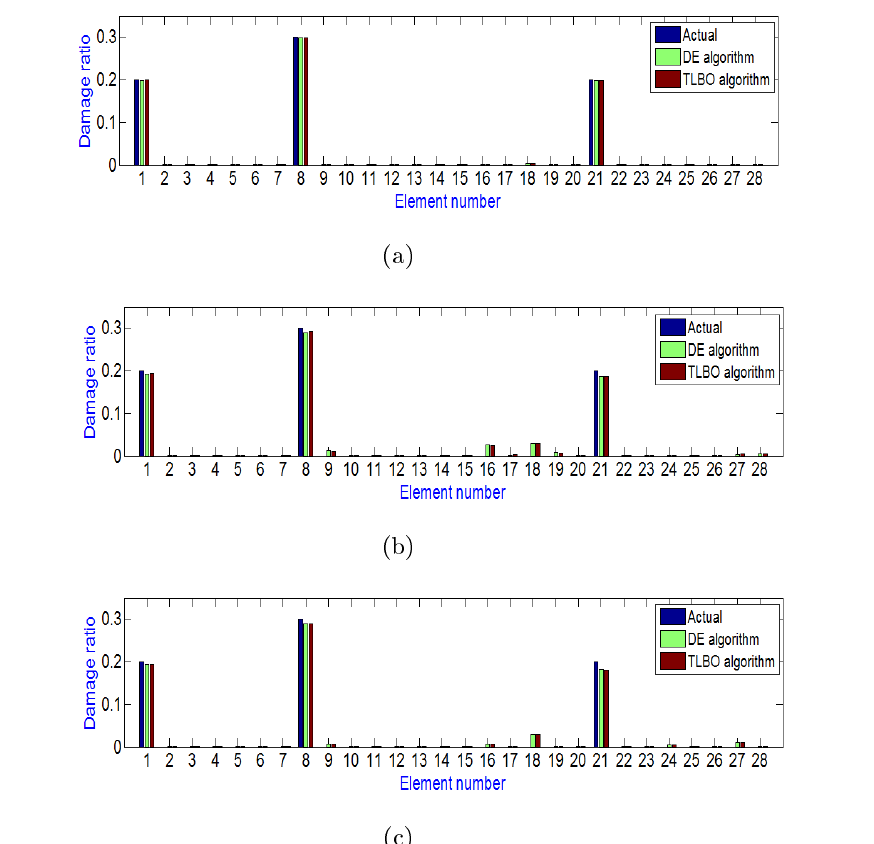
Fig. 3. Comparison of damage detection results obtained from two optimization algorithms for case 2 of the frame: (a) without noise, using 32 translational DOFs; (b) with noise, using 32 translational DOFs; (c) with noise, using 20 translational